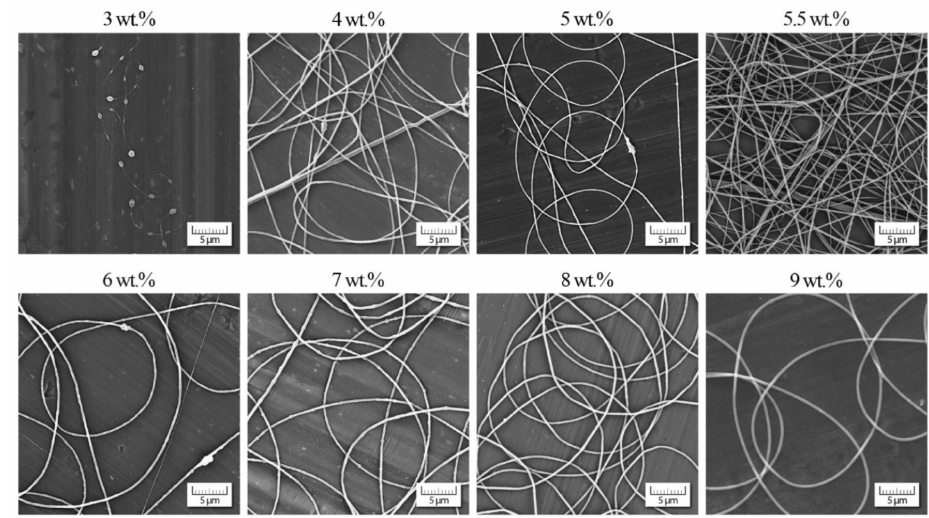
Figure 7. Morphology of individual nanofibers in dependence on PEO concentration.